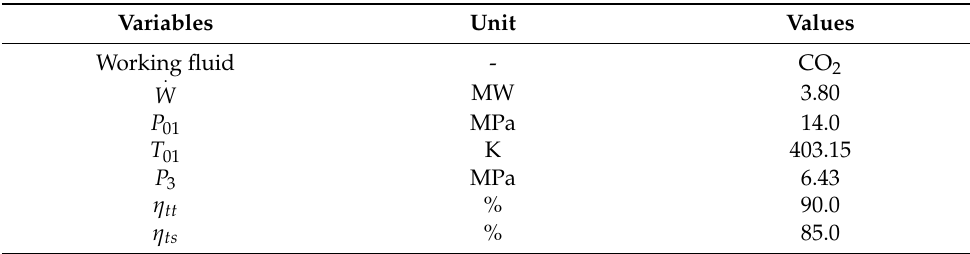
Table 1. Design conditions for a radial outflow